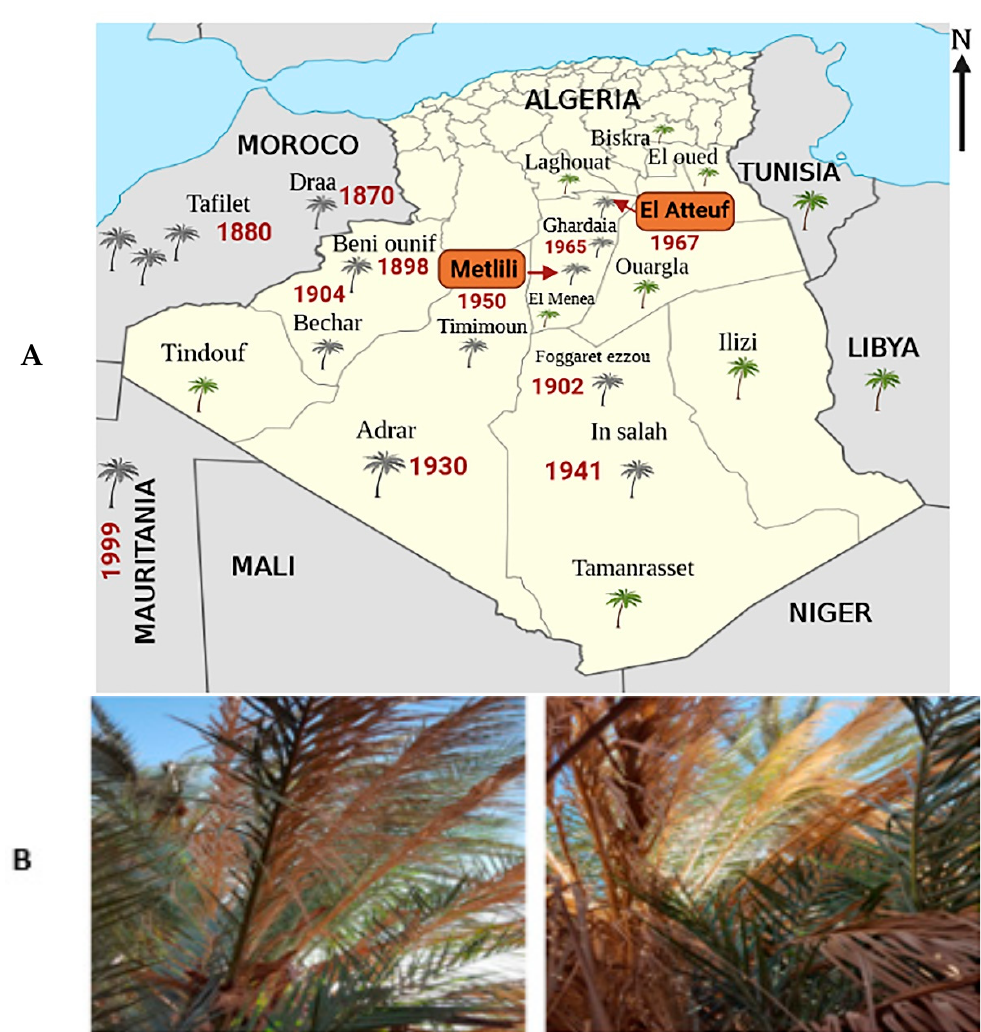
Figure 1. The spread of Bayoud disease in North Africa and Algeria. Location of sampling sites ( A ). Bayoud disease symptoms on infected palms ( B ).